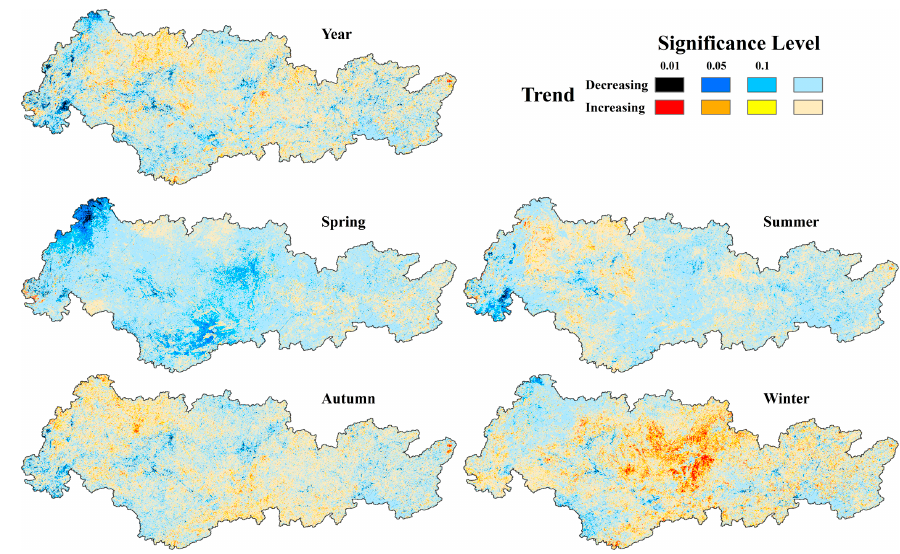
Figure 7. Spatiotemporal changes and significance level in yearly and seasonal ET in the PRB.